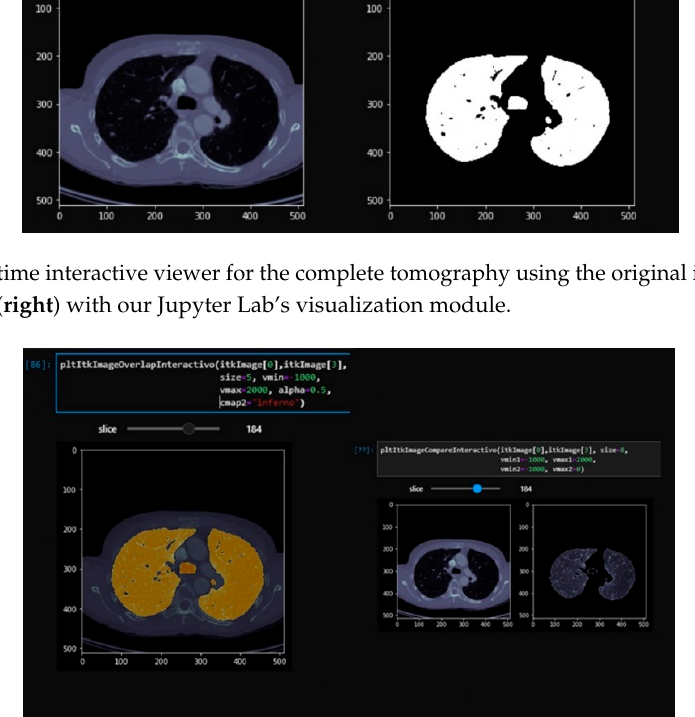
Figure 4. Real-time interactive viewer for the complete tomography with overlapping segmentation and the original image ( left ). The original tomography and segmentation of lung without vascularization is on the right . Visualization with our Jupyter Lab’s visualization module.